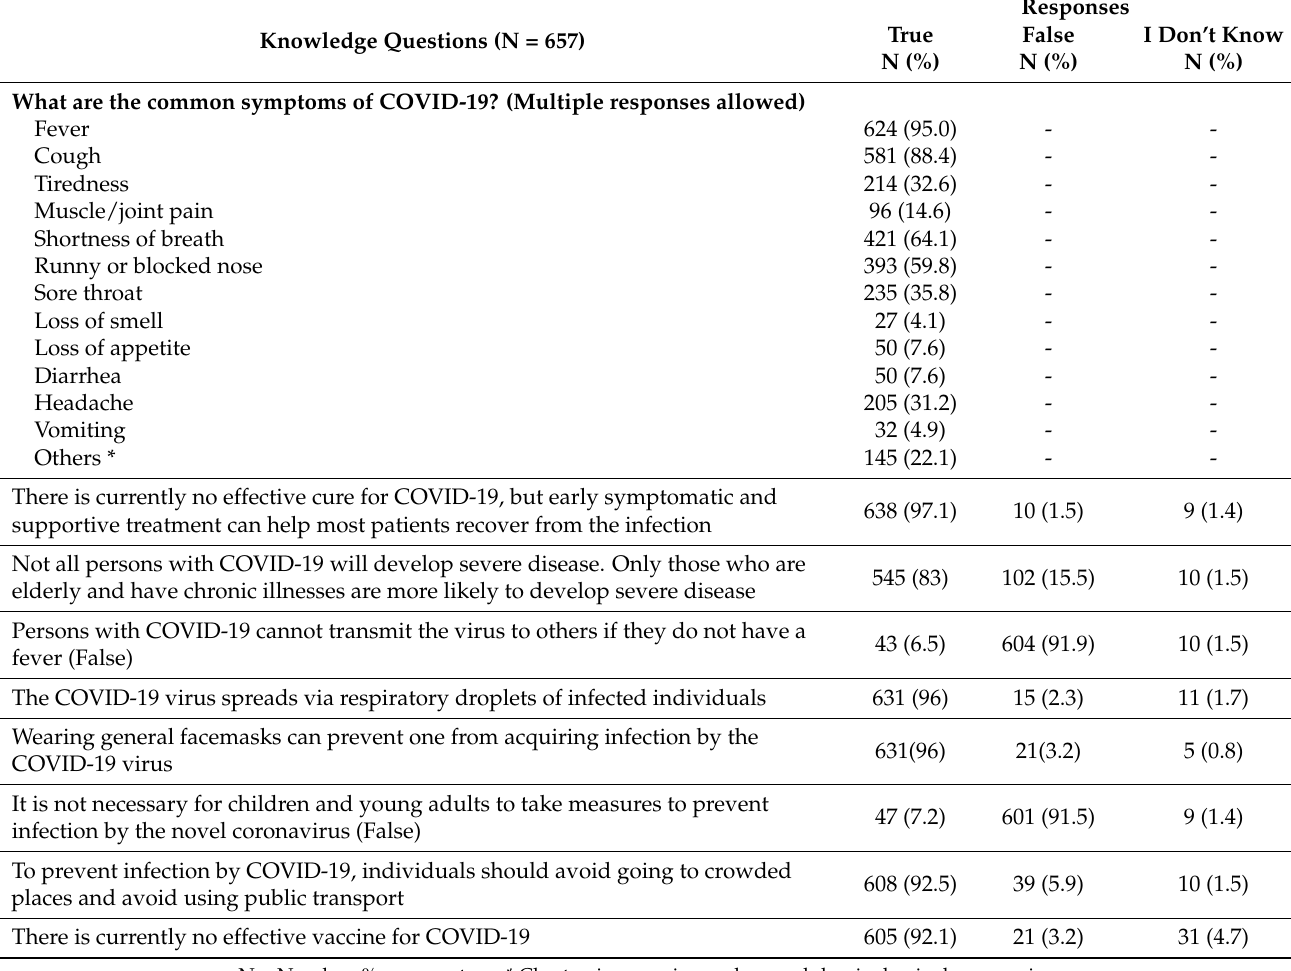
Table 2. Descriptive summary of COVID-19 knowledge among HCWs in Uganda.